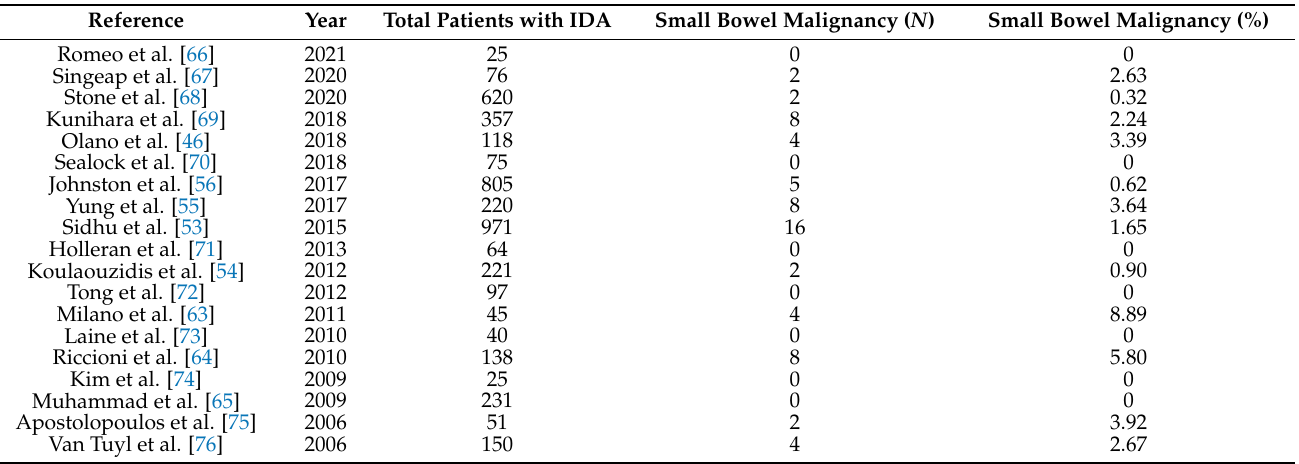
Table 1. Studies on the frequency of small bowel malignancies in patients who underwent capsule endoscopy for iron deficiency